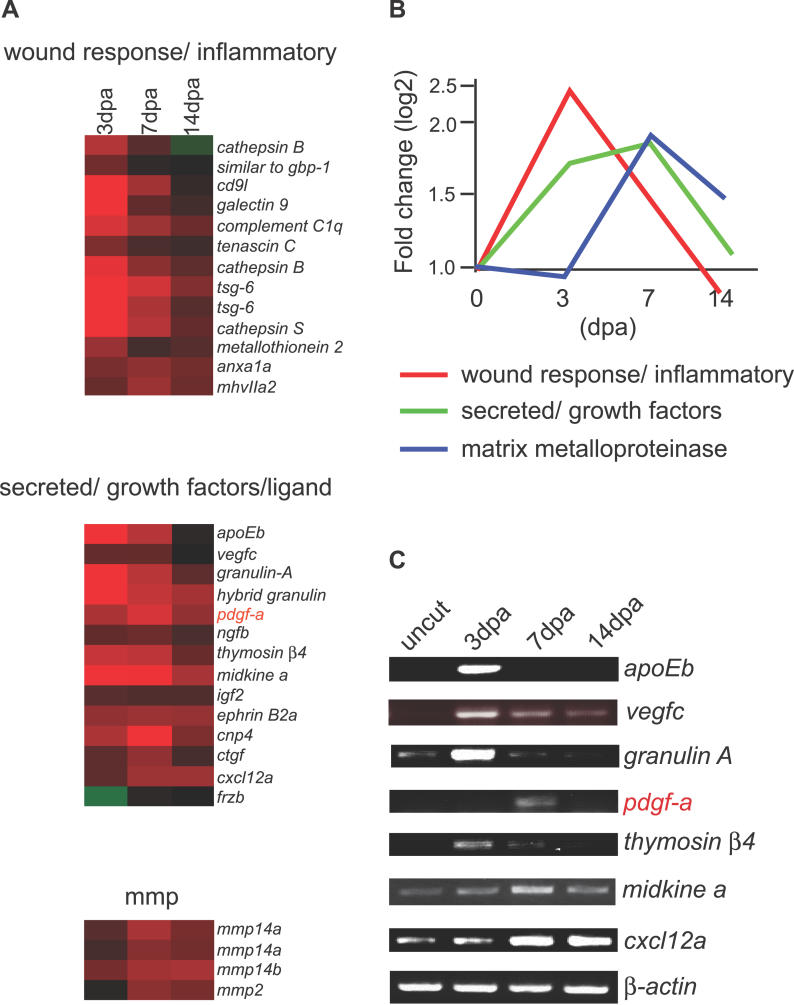
Wound Response/Inflammatory Factors, Secreted Molecules, and MMPs Are Upregulated during Zebrafish Heart Regeneration(A) Genes encoding wound response and inflammatory factors, secreted molecules, and MMPs were clustered based on their expression patterns at 3, 7, and 14 dpa. The gene name, gene symbol, and fold change of each gene can be found in
Dataset S1. The color chart indicates fold change of expression, and red and green represent increased and decreased expression, respectively.
(B) General trend and average fold change of expression of wound response/inflammatory genes, secreted molecules, and MMPs. The wound response/inflammatory genes are expressed early (peak at 3 dpa) during zebrafish heart regeneration. Genes coding for secreted molecules begin to express at 3 dpa and the expression level reach a peak at 7 dpa. The MMPs start to express at 7 dpa and last until 14 dpa.(C) Semiquantitative RT-PCR of a subset of genes coding for secreted molecules, including
apoEb (apolipoprotein Eb), vegfc (vascular endothelial growth factor c), granulin A, pdgf-a (platelet-derived growth factor-a; labeled in red)
, thymosin β
4, midkine a,
and cxcl12a (chemokine (c-x-c motif) ligand 12a). β
-actin was used as a loading control. The RT-PCR results confirmed the temporal expression patterns of these genes as determined by microarray analysis.